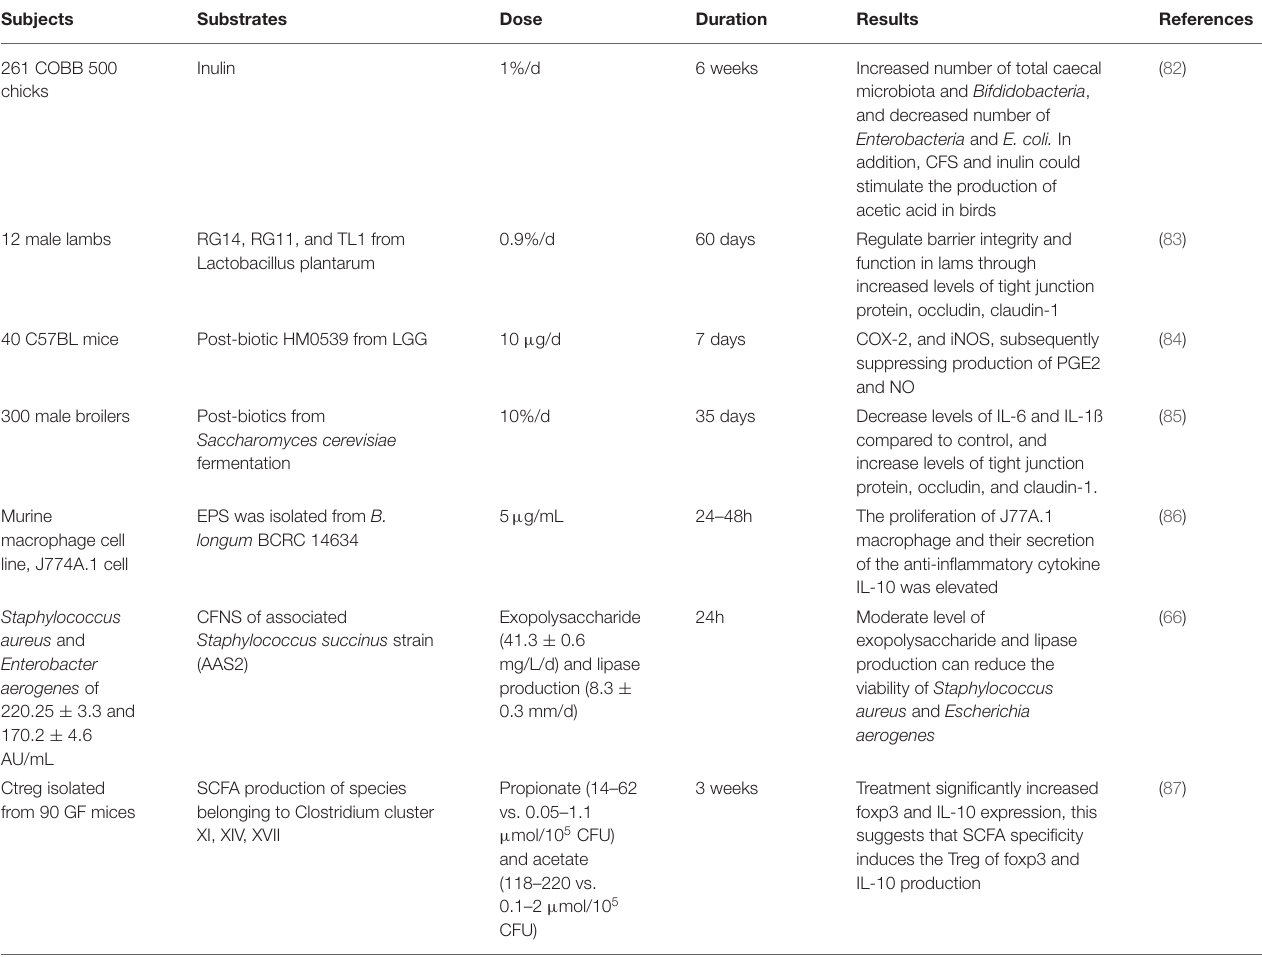
TABLE 3 | Example of studies designed to determine effects of post-biotic on gut microbiota and immune